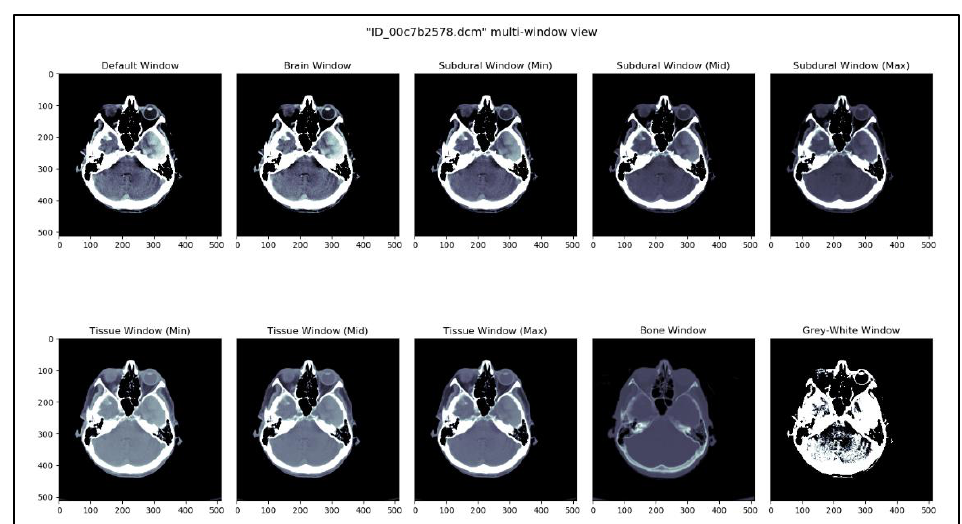
Figure 3. DICOM image viewed in 10 different window settings.